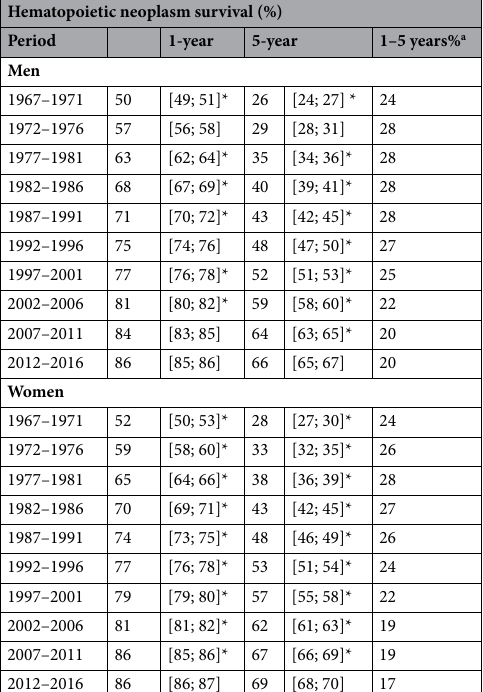
Table 3. Relative survival percent, 95% confidence intervals and survival difference between year 1 and 5 for hematopoietic malignancy patients aged 0–89 years in Sweden 1 and 5 years after diagnosis. a 1–5 years% is the difference between survival percentages of year 1 and 5. *Indicates that the 95%CIs between periodic survival percentages do not overlap, compared to the period